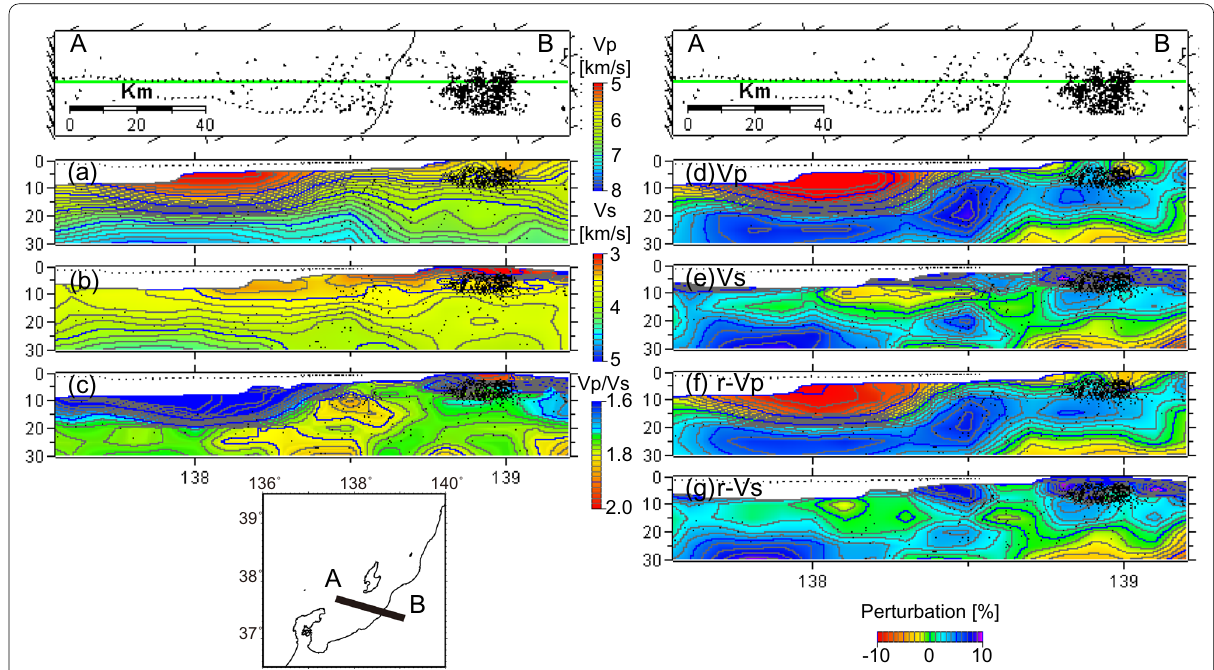
Fig. 23 Seismic velocity structure and restored resolution test along the reflection survey line near the 2007 offshore Chuetsu